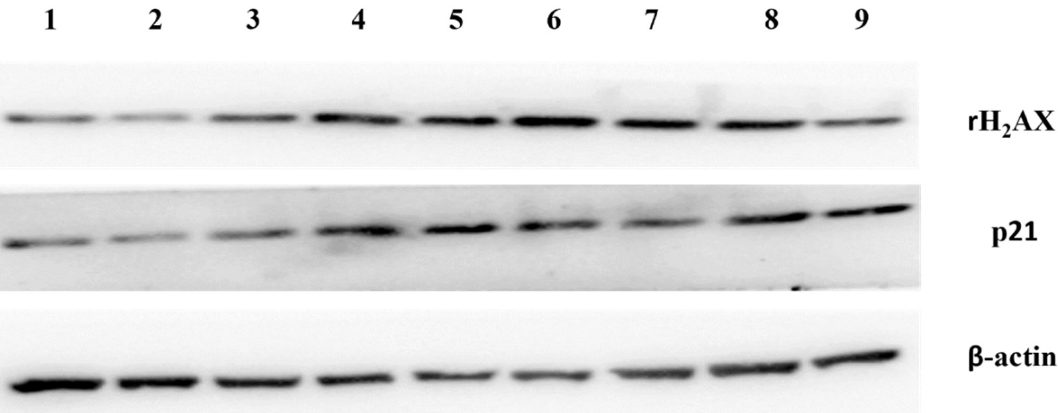
Figure 5. Western blotting showing increased levels of γH2AX and p21 in healthy first trimester placental explants that had been treated with large and small EVs derived from missed miscarriage placentae (1–3: controls; 4–6: large EVs treated; 7–9: small EVs treated).